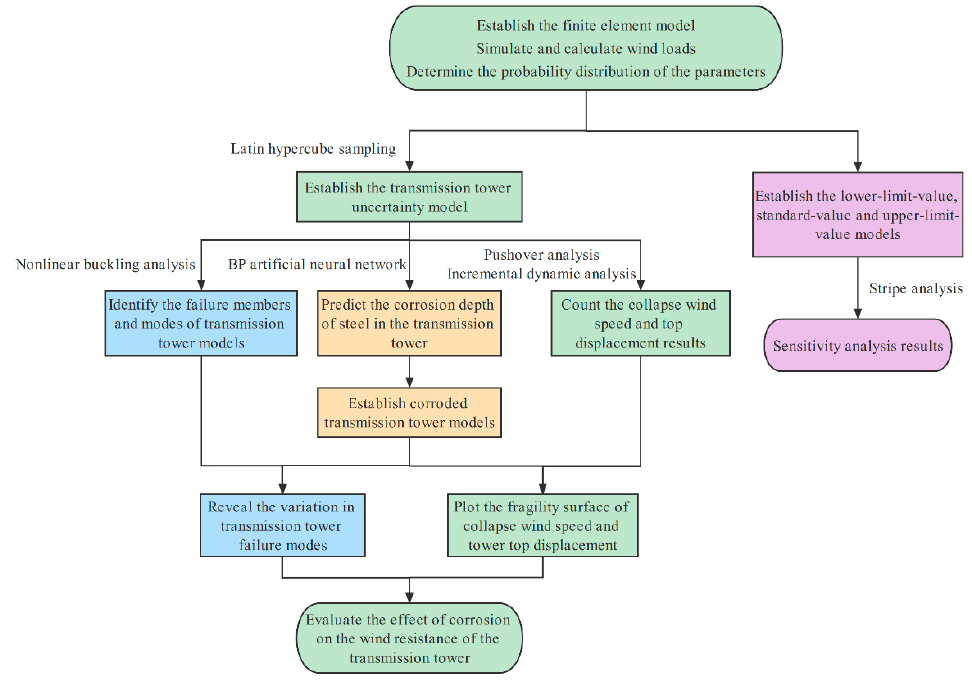
Figure 1. Proposed procedure of the wind resistance evaluation method for the transmission tower.